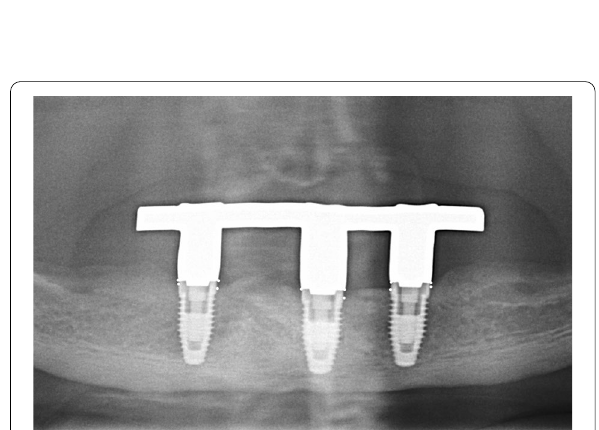
Fig. 3 Exemplary radiograph of the implant group HD‑TiUnite with machined collar (Nobel Biocare AB, Zurich,